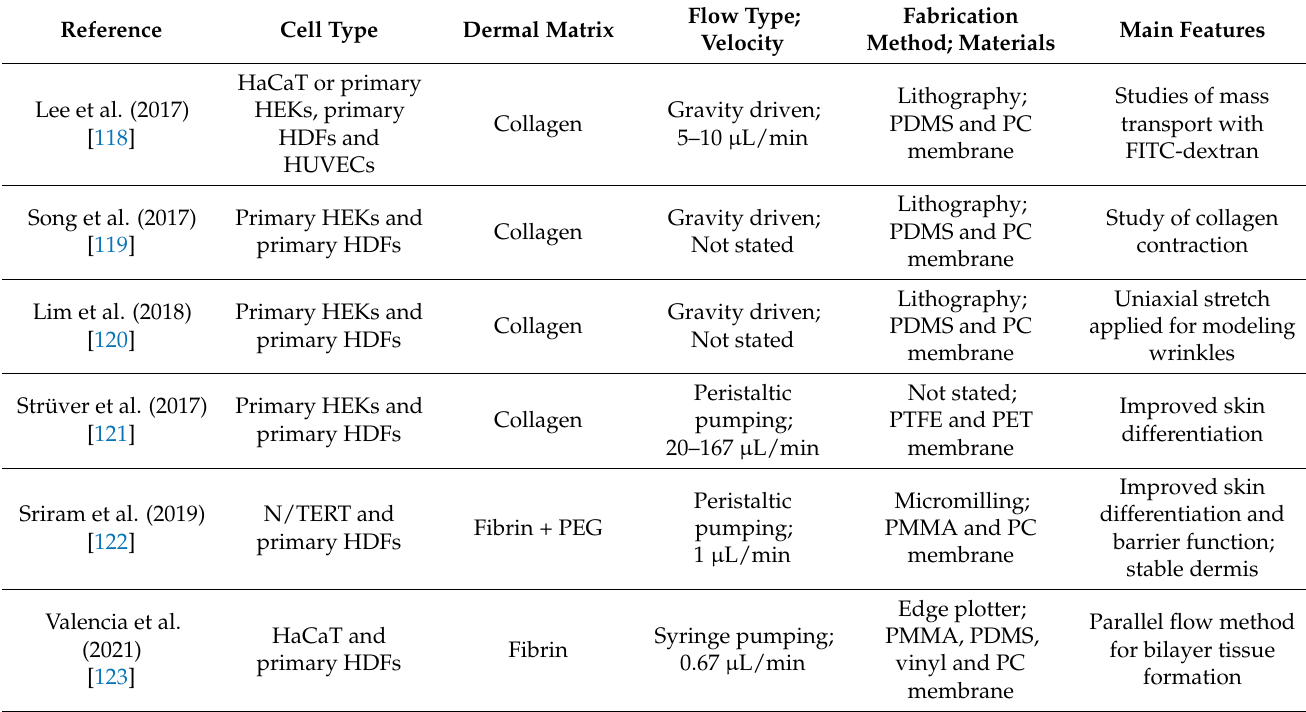
Table 3. Summary of the 3D SoC with basal perfusion reported in the literature. Abbreviations: HEKs, human epidermal keratinocytes; HDFns, human dermal fibroblasts; HUVECS, human umbilical vein endothelial cells; PEG, polyethylene glycol; FDM, fibroblast-derived matrix; PS, polystyrene; ECM, extracellular matrix; FN, fibronectin; G, gelatin; PDMS, polydimethylsiloxane; PC, polycarbonate; PTFE, polytetrafluoroethylene; PET, polyethylene terephthalate; PMMA, poly(methylmethacrylate); FITC, fluorescein isothiocyanate; TEER, transepithelial electrical